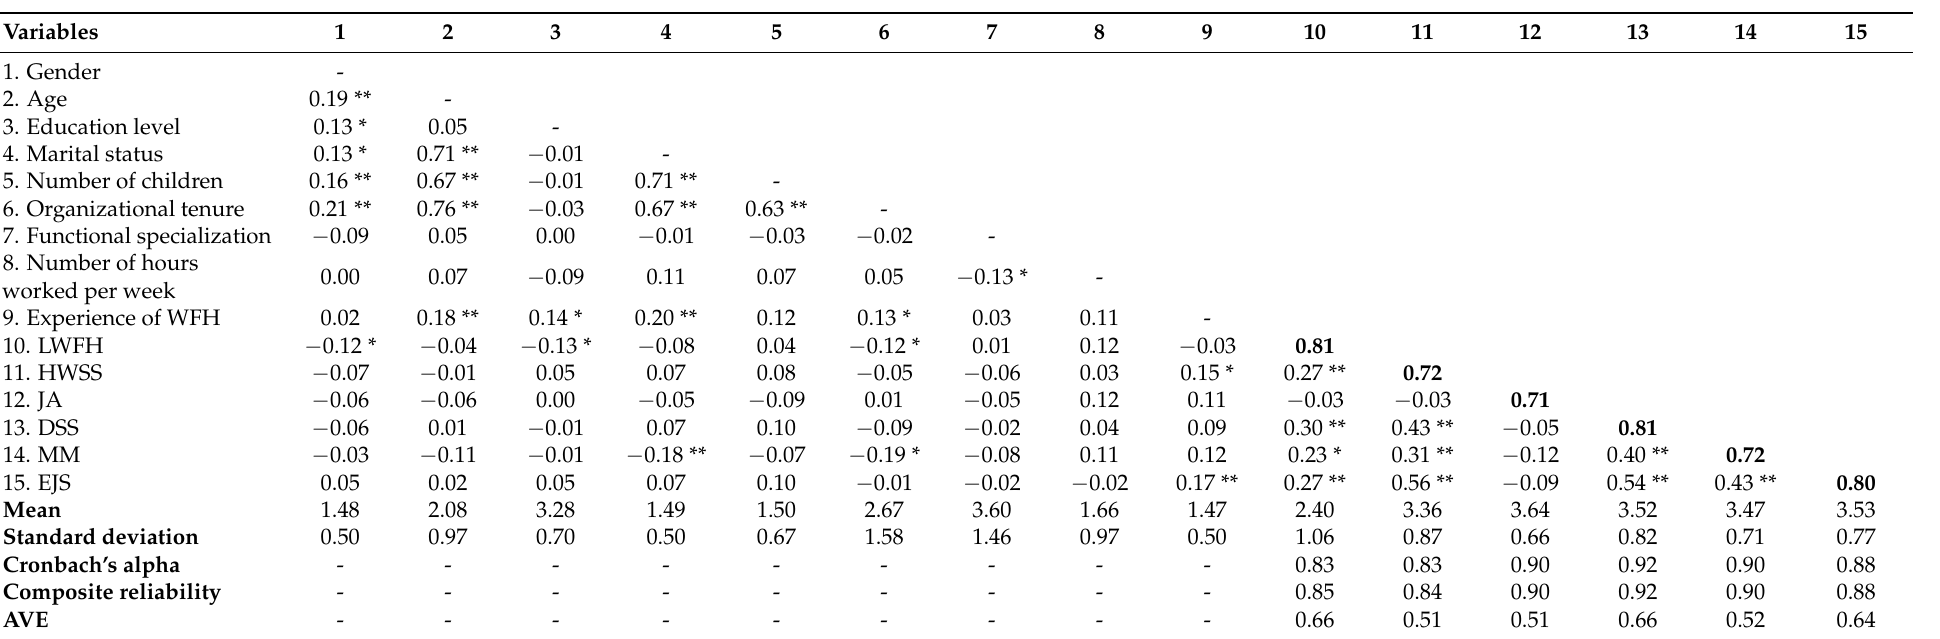
Table 2. Means, standard deviations, and assessment of convergent and discriminant validity of reflective